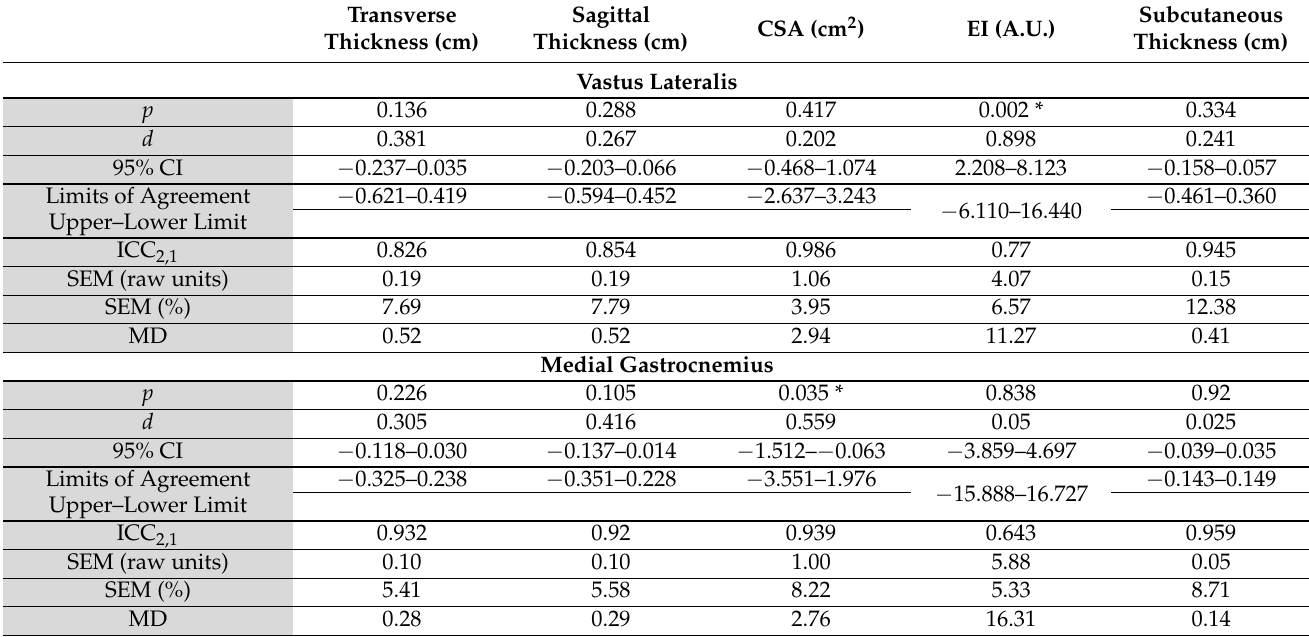
Table 2. Statistical outcomes for the image acquisition comparisons between the experienced versus novice sonographers. * = statistically significant difference between sonographer